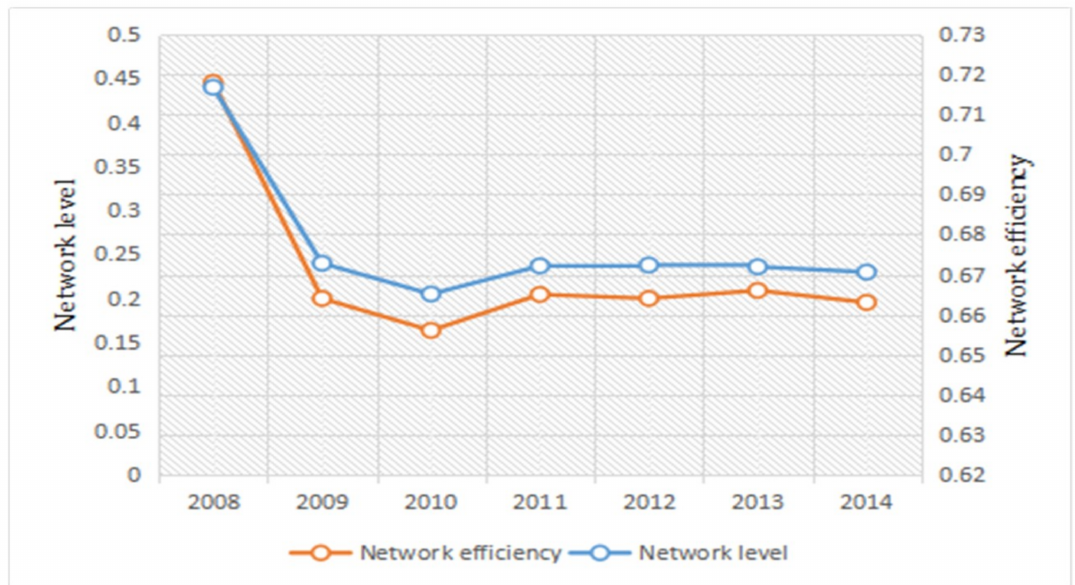
Figure 3. Network level and network efficiency evolution